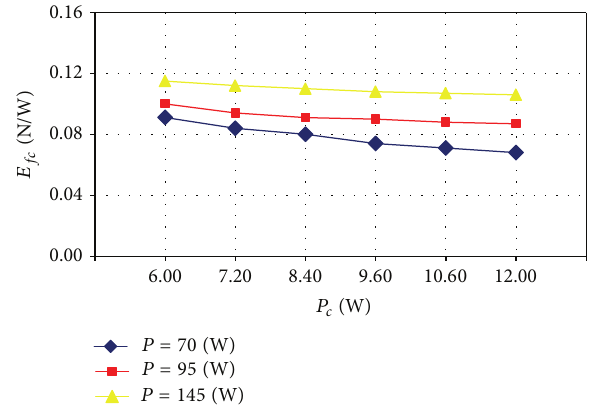
Figure 14: Variation of the tail boom efficiency 𝐸 𝑓𝑐 according to the lateral force 𝐹 and the required power 𝑃 𝑐 throughout the three functioning stages of the main rotor at a pitch angle 𝑝 = 8 ∘